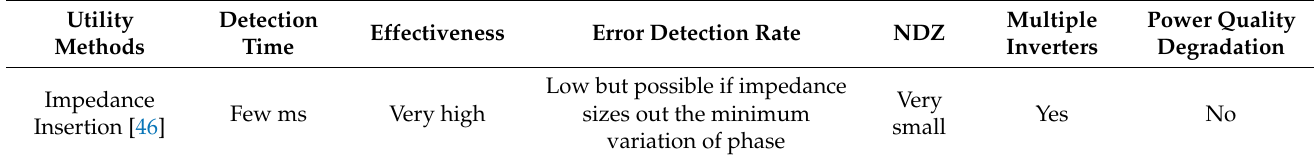
Table 5. Resume of the utility islanding methods presented in this